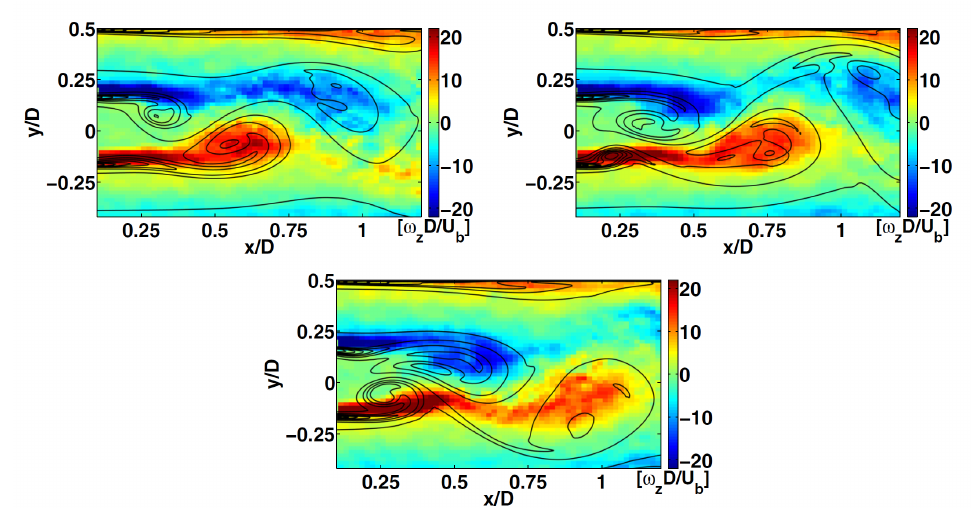
Figure 14. Snapshots from the vortex-shedding cycle showing spanwise vorticity in the vertical symmetry plane (for geometry, see Figure 3b). Comparison between simulations using the RSM-BSL model (black contours) and PIV experiments (colored contours). Figure adapted from [25]. Reprinted with permission from Springer